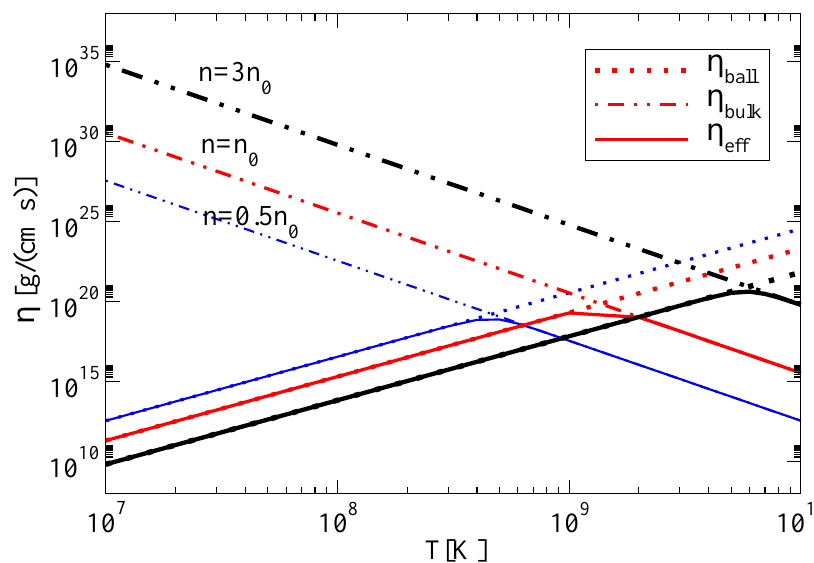
Figure 4. Phonon contributions to the shear viscosity as a function of temperature for different particle densities in terms of the saturation density n 0 . We show the ballistic viscosity η ball , the hydrodynamic viscosity η bulk , and the effective description η eff . Figure adapted from